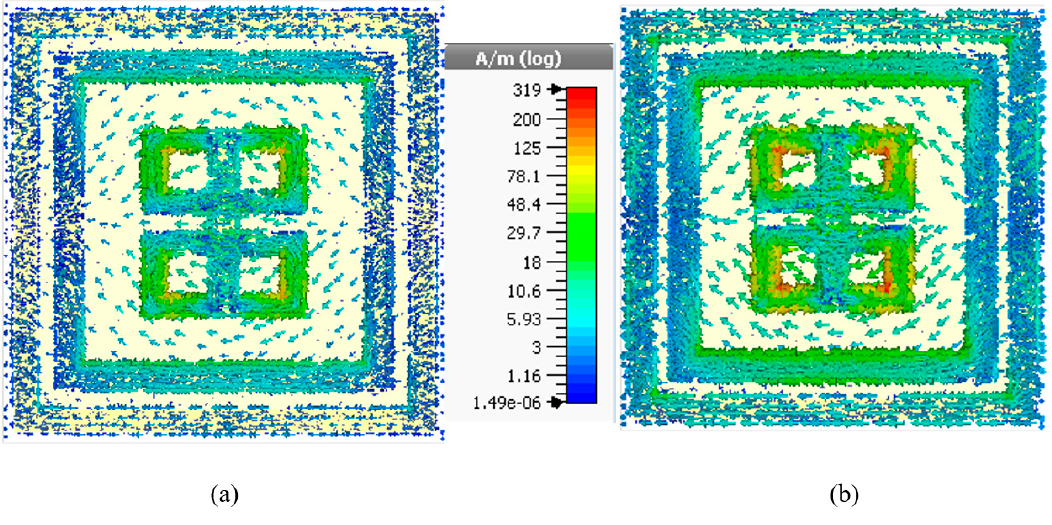
Figure 5. Surface current distribution of proposed MM absorber ( a ) 13.78 GHz, ( b ) 15.3